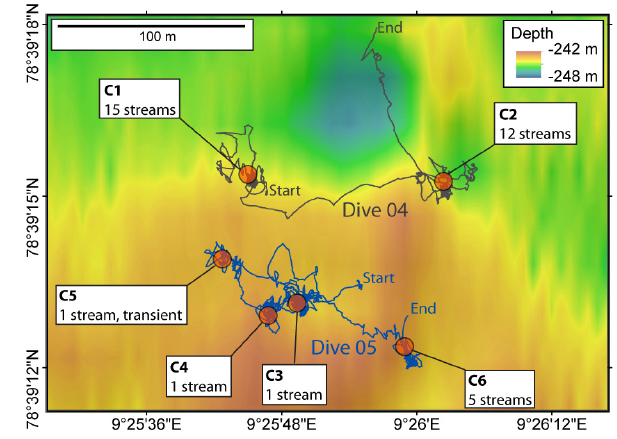
Figure 6. Bubble stream clusters (C1 to C6) in Area 2 discovered during ROV Dive 04 and 05. Dive tracks are shown on bathymetry.